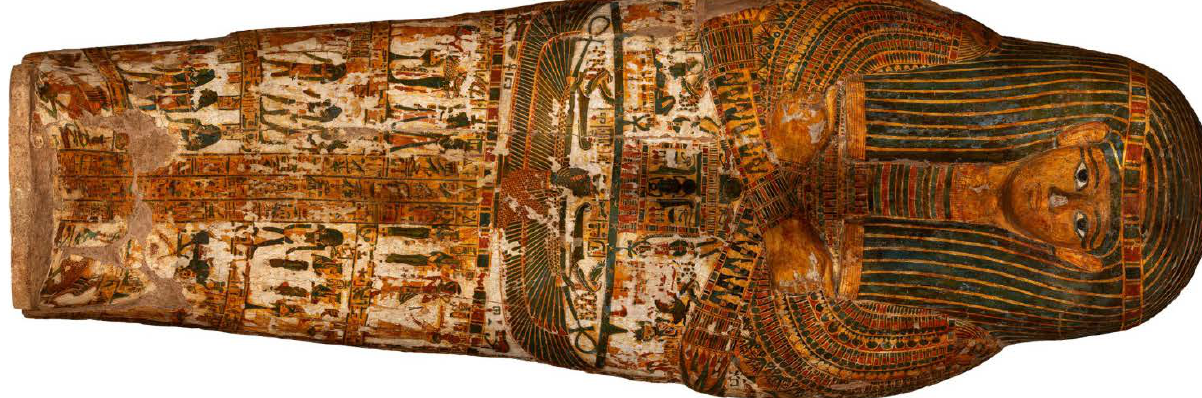
Figure 16. High-resolution orthophoto of the